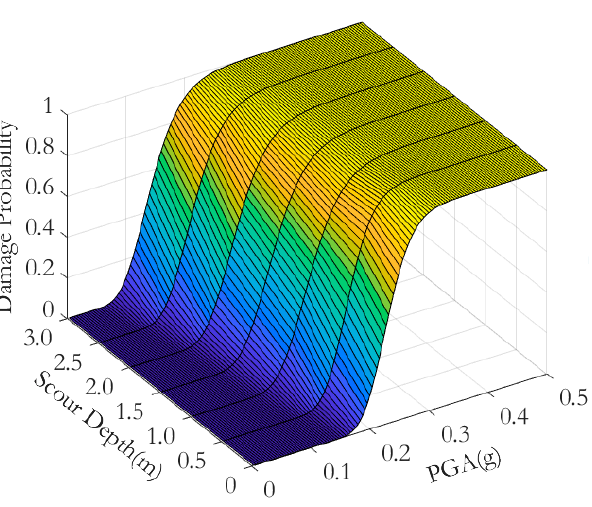
Figure 10. Fragility surface of scoured foundation at the moderate damage state: darker color denoted low damage probability and brighter color denoted high damage probability.